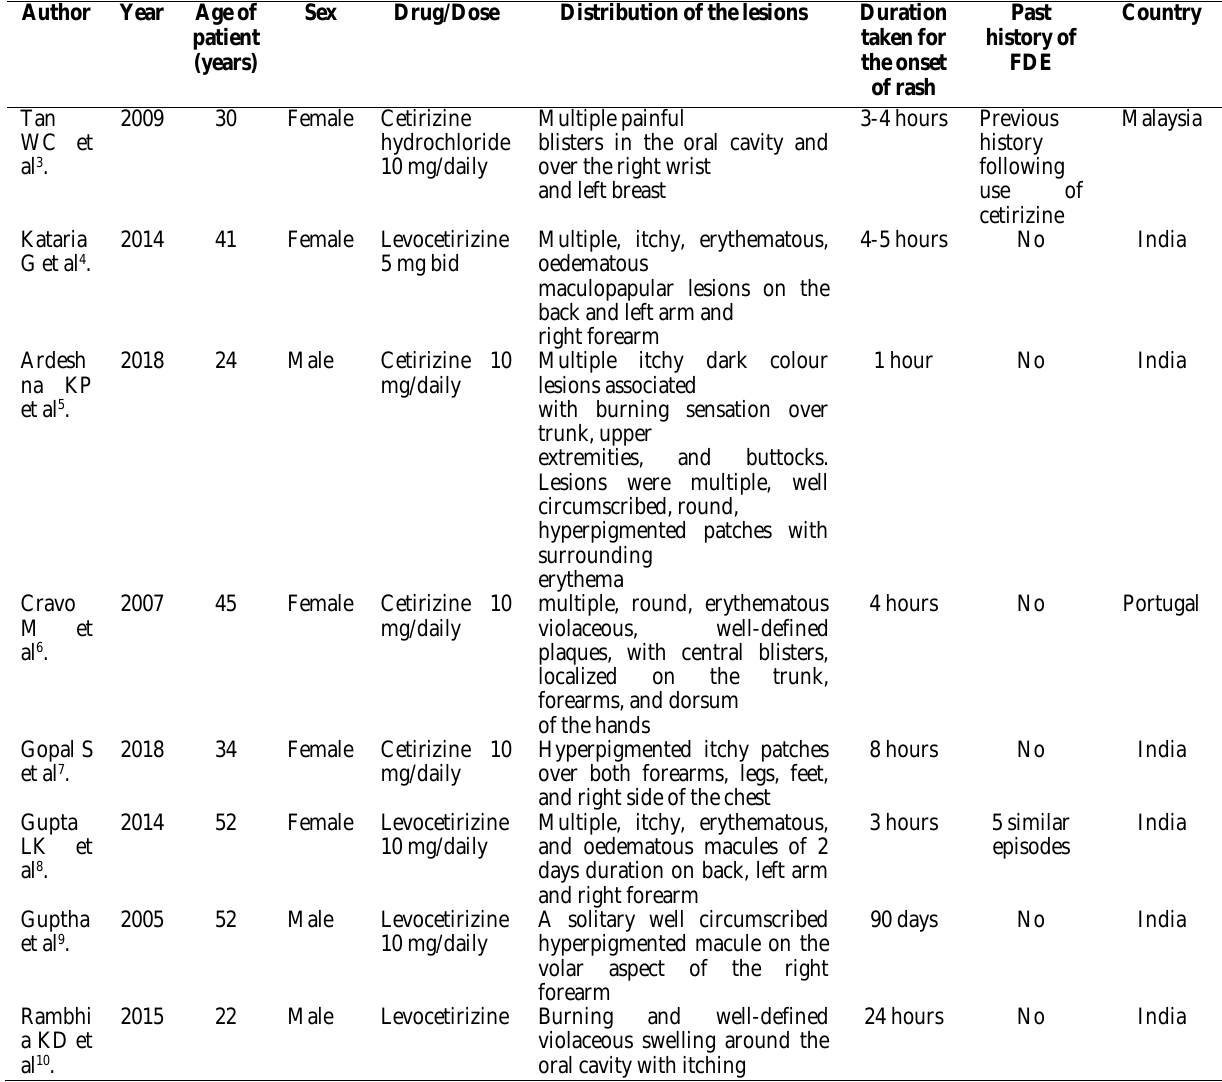
Table 1: Previous documented cases of second-generation antihistamine induced FDE.